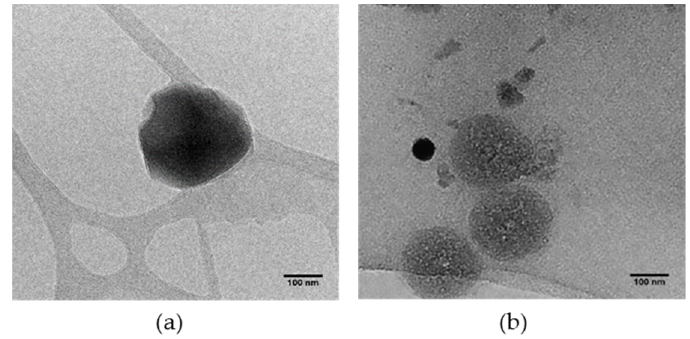
Figure 7. TEM images of ( a ) RES-NS and ( b ) OXY-NS.